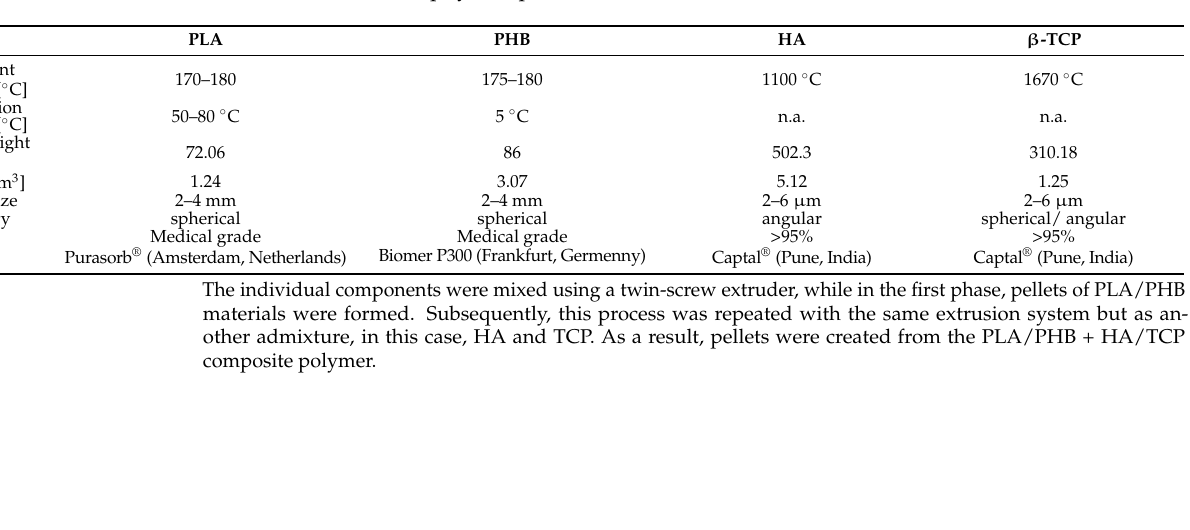
Table 1. Chemical and physical parameters of the materials